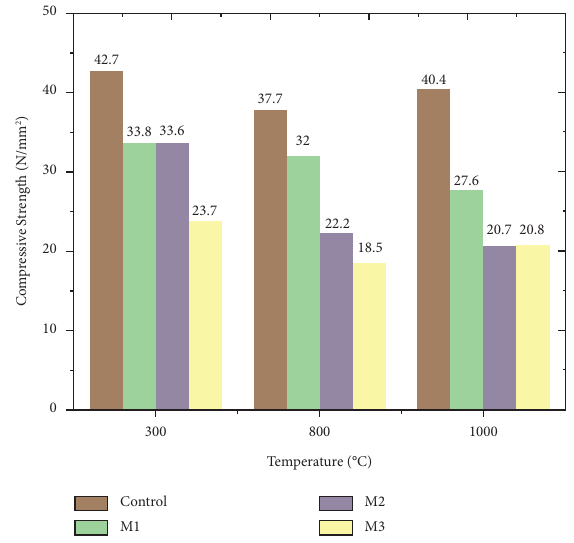
Figure 12: Compressive strength of concrete samples at varying temperatures.